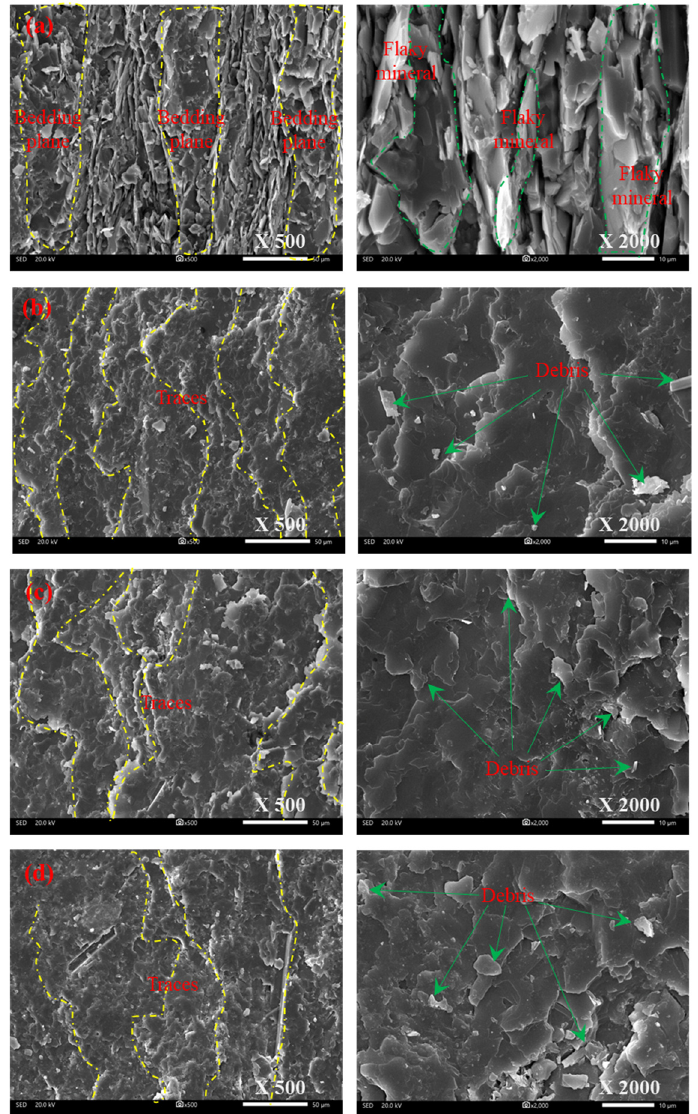
Figure 15. SEM photos of the fracture surfaces for phyllite subjected to shear failure in uniaxial compression: ( a ) S-D-0; ( b ) S-W-45; ( c ) S-D-60; ( d ) S-W-60.